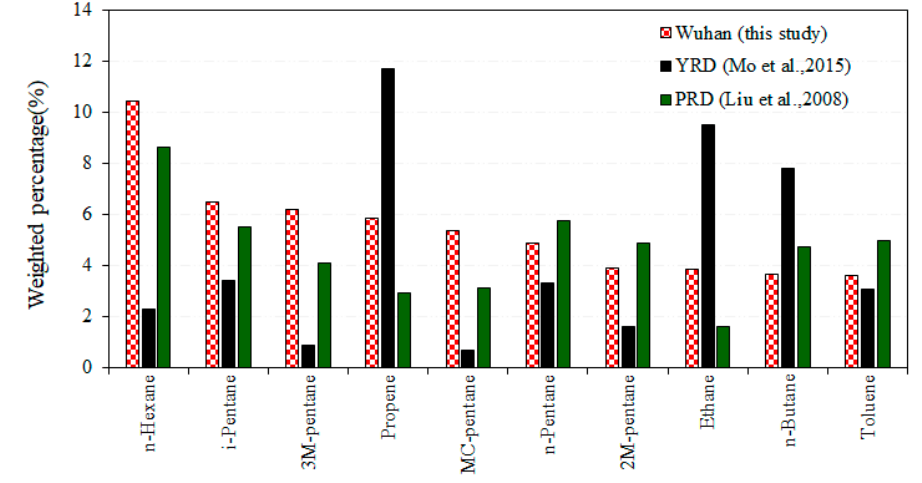
Figure 4. Comparison of major VOC species from the petrochemical industry in different regions.